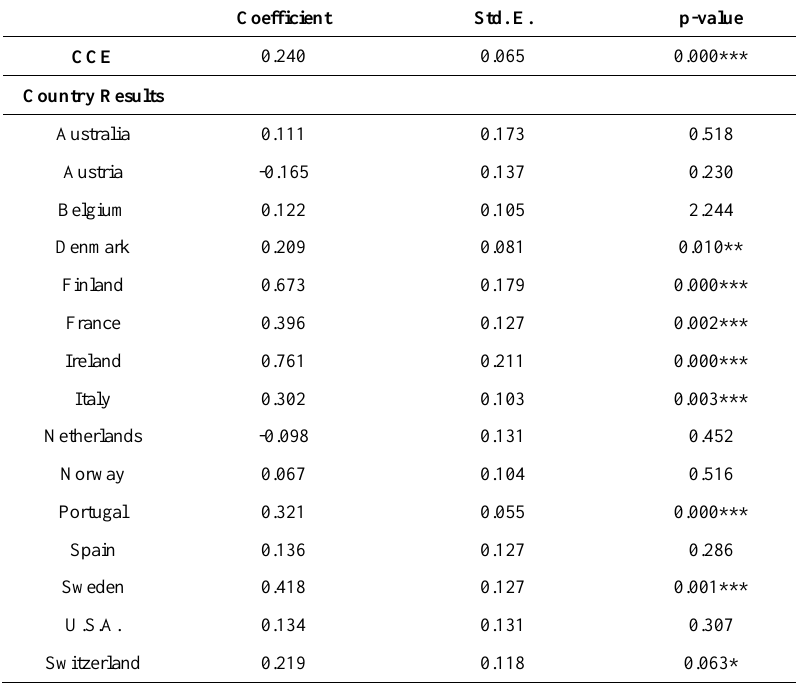
Table 6. Common Corelated Effect (CCE)